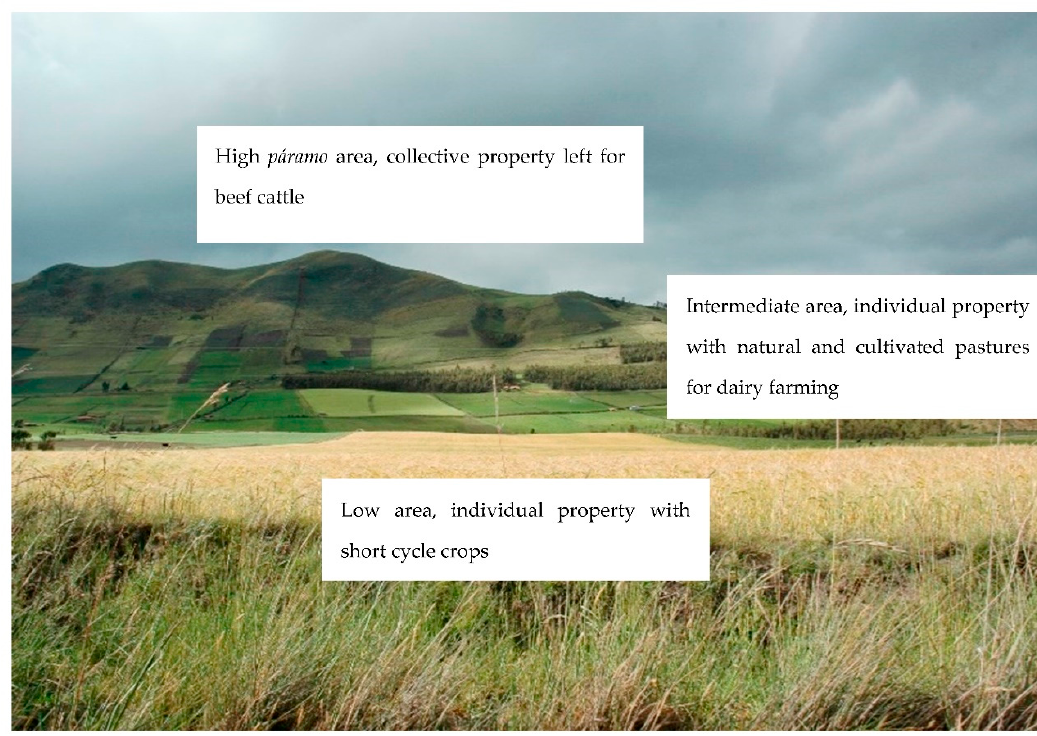
Figure 5. Community zoning by different altitudinal strata and soil suitability.